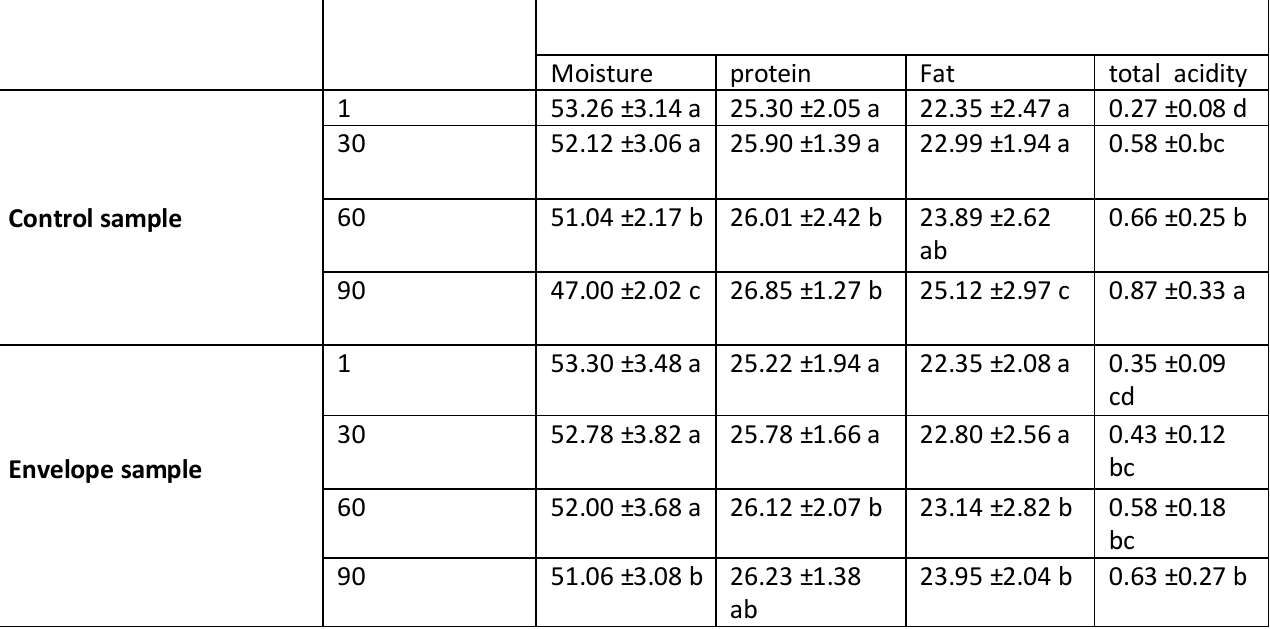
Table 1: Chemical analysis of mozzarella cheese packaged with green tea extract casings during storage